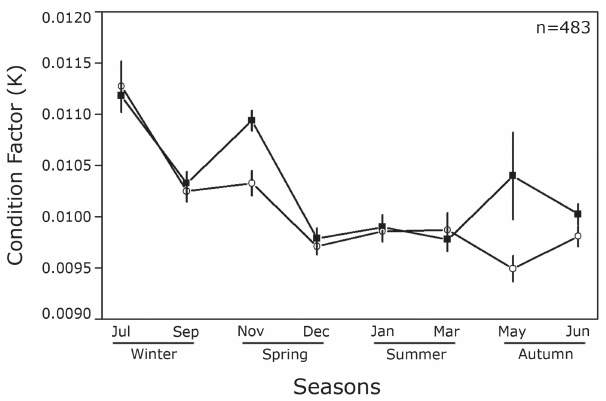
Fig. 7. Mean values (± standard error) of the condition factor among months and seasons (black square = females; white circle = males) of Cetengraulis edentulus in Guanabara Bay.